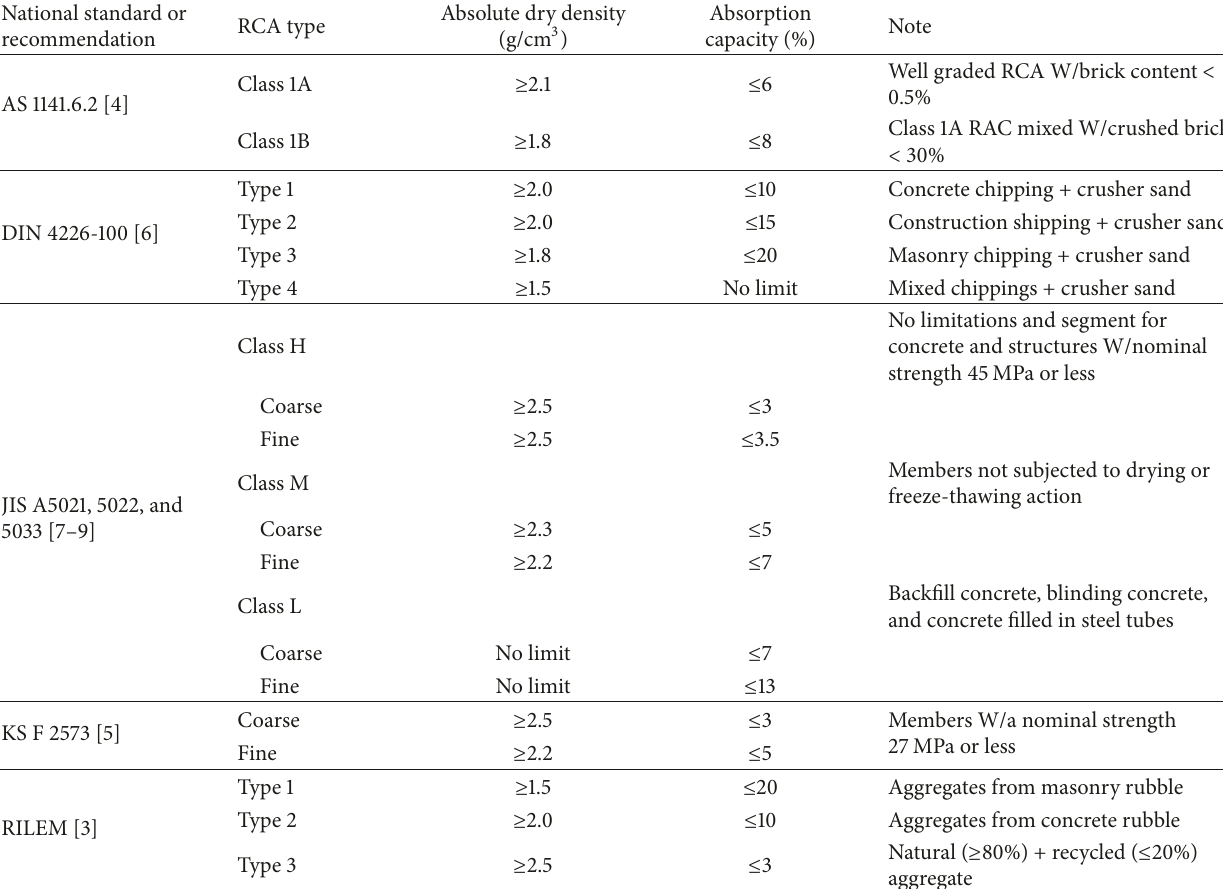
Table 1: Minimum criteria for recycled aggregate for various